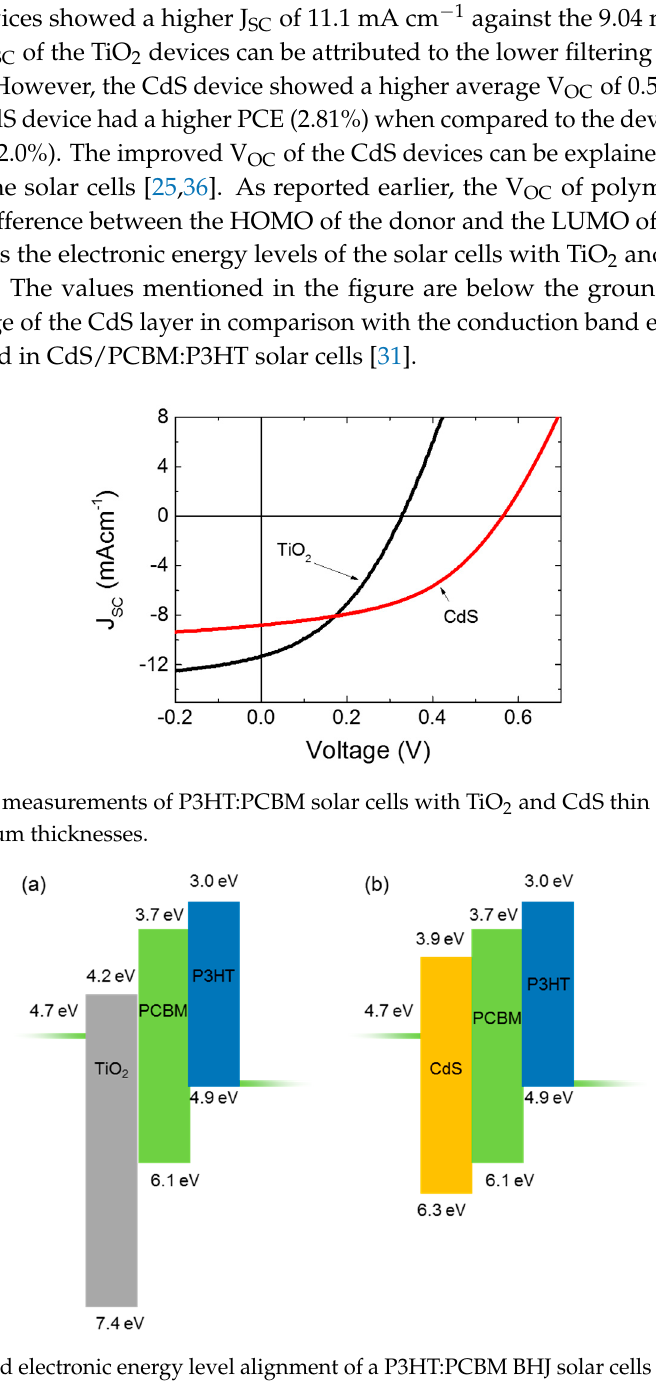
Figure 6. Proposed electronic energy level alignment of a P3HT:PCBM BHJ solar cells with ( a ) TiO 2 and ( b ) CdS as the hole-blocking layer with ITO and MoO 3 /Ag as bottom and top electrodes, respectively.